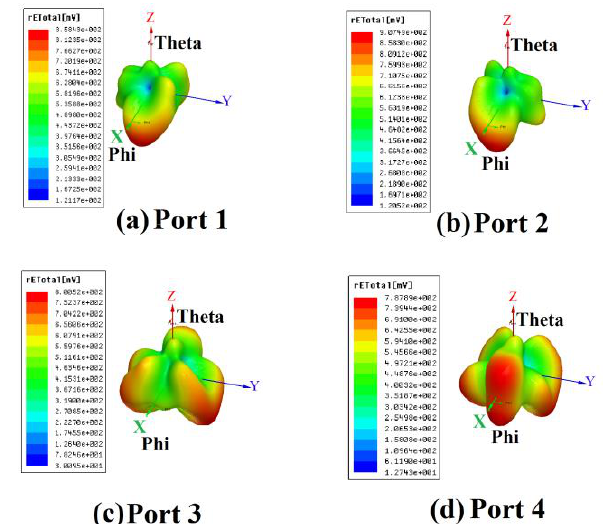
Figure 3: 3D radiation pattern of the proposed